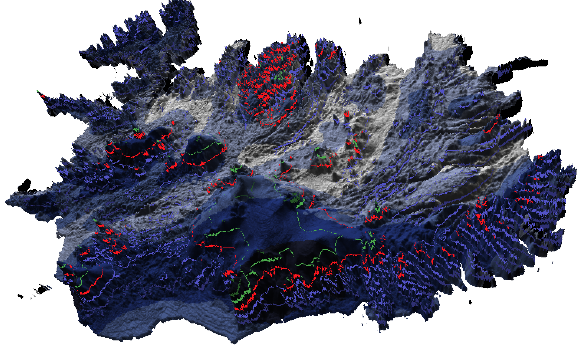
Figure 13. Render identical to Fig. 12 using rainfall data to change the surface